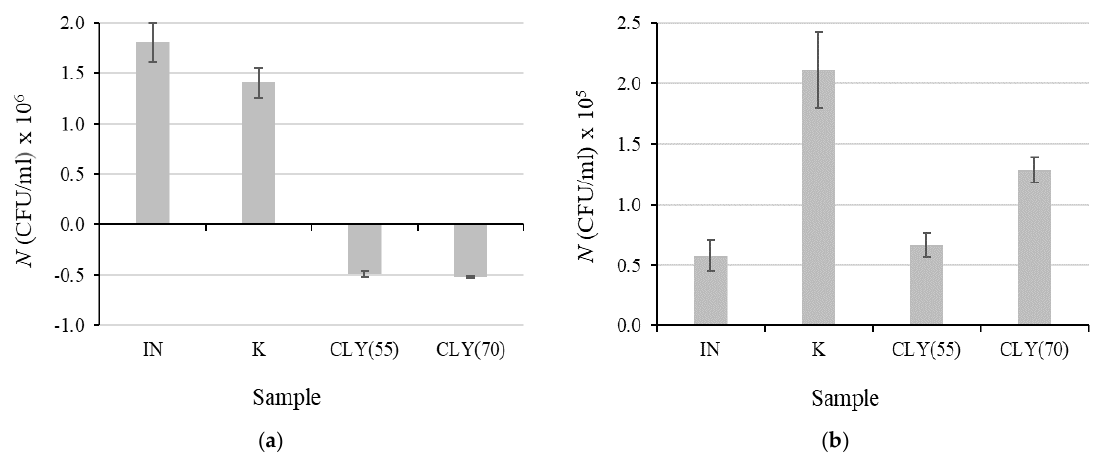
Figure 4. Difference between the numbers of viable bacteria cells, ∆ N , after and before 2 h of incubation for E. coli ( a ) and S. aureus ( b ) in inoculum (IN) alone and in the presence of samples K, CLY(55) or CLY(70). The numbers on the x axis denote the number of the CLY sample.